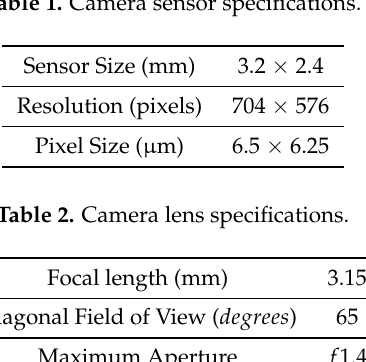
Table 1. Camera sensor specifications.